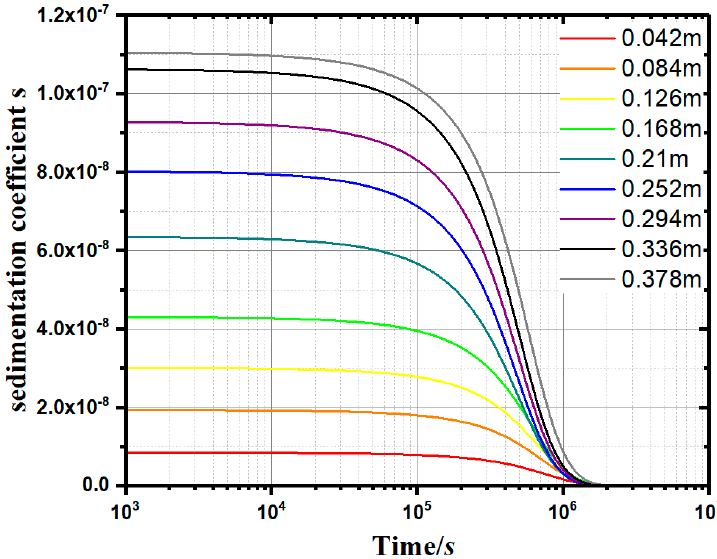
Figure 9. Sedimentation coefficient curves (0.1g/L apple pectin experimental group).